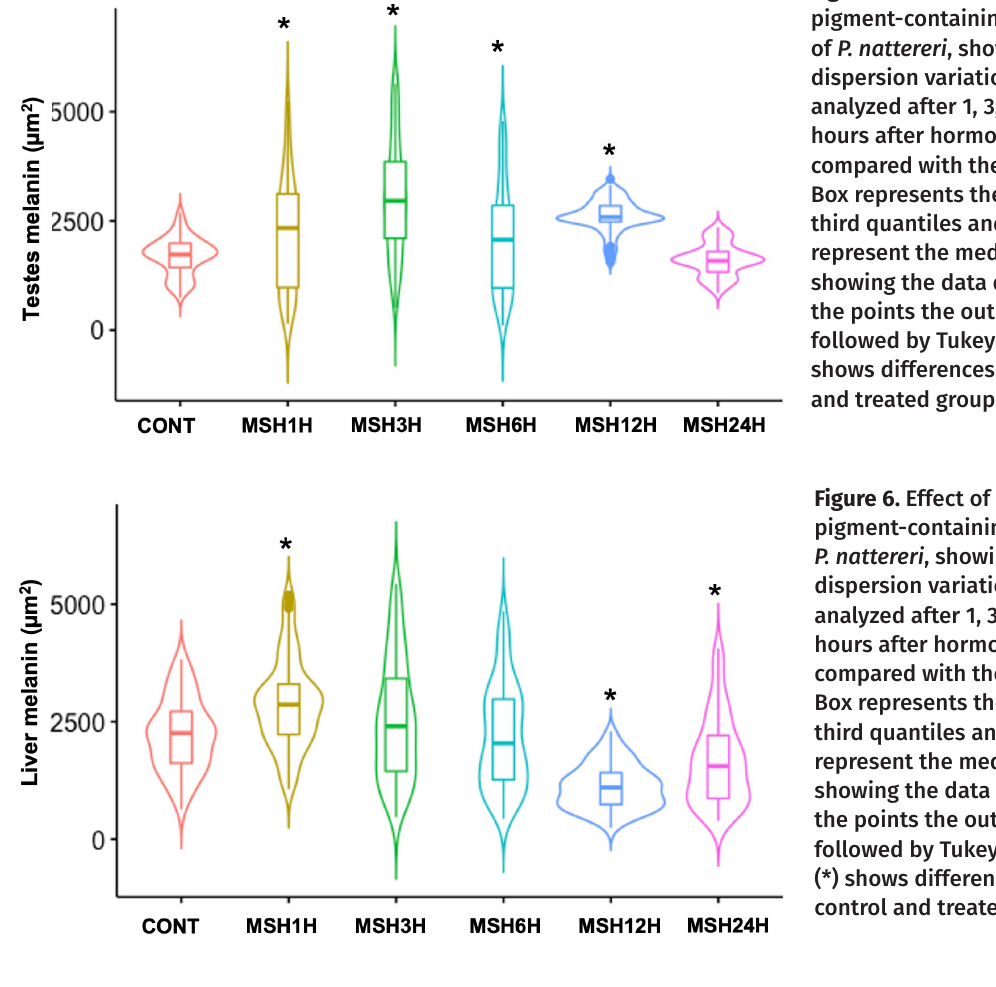
Figure 5. Effect of α-MSH in the pigment-containing area of testes of P. nattereri , showing the melanin dispersion variation within cells, analyzed after 1, 3, 6, 12 and 24 hours after hormonal treatment, compared with the control group. Box represents the first and third quantiles and lines inside represent the median. Violin showing the data distribution and the points the outliers. ANOVA followed by Tukey test ( P <0.05). (*) shows differences between control and treated groups.